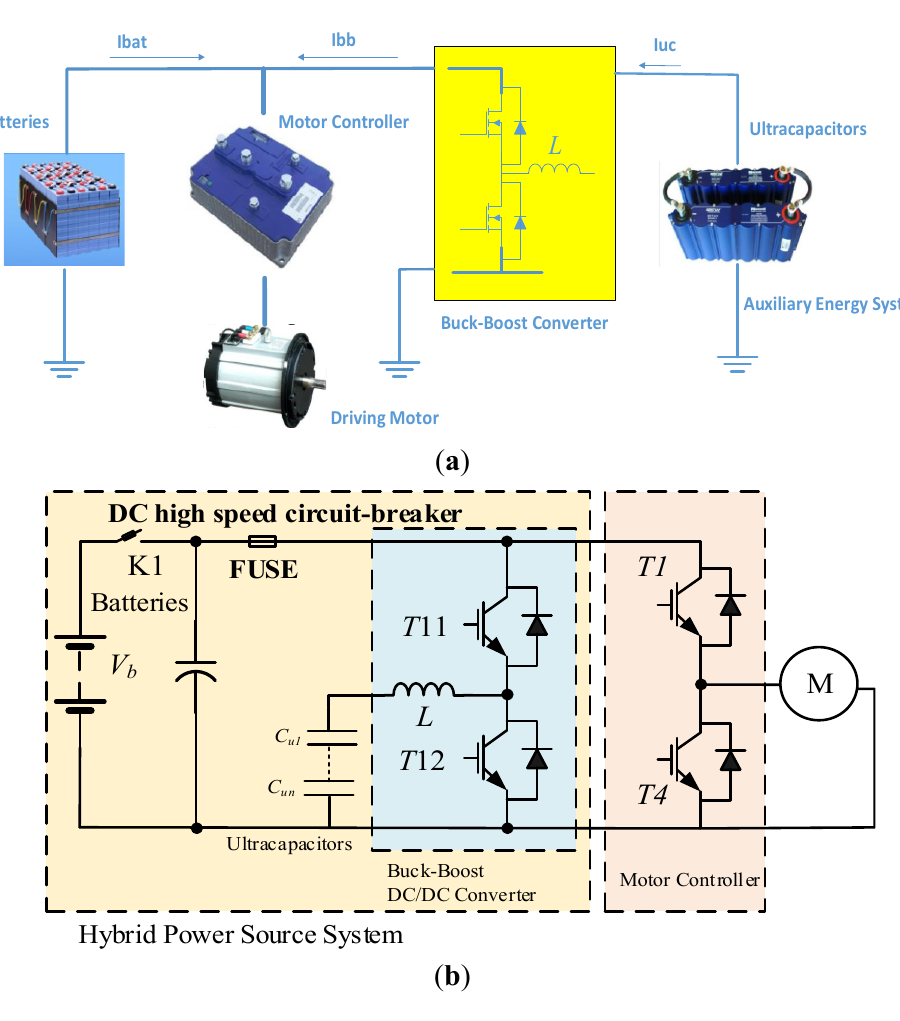
Figure 1. Proposed hybrid power source for EVs. ( a ) System configuration of hybrid power source system for EVs; ( b ) internal power circuit topology of